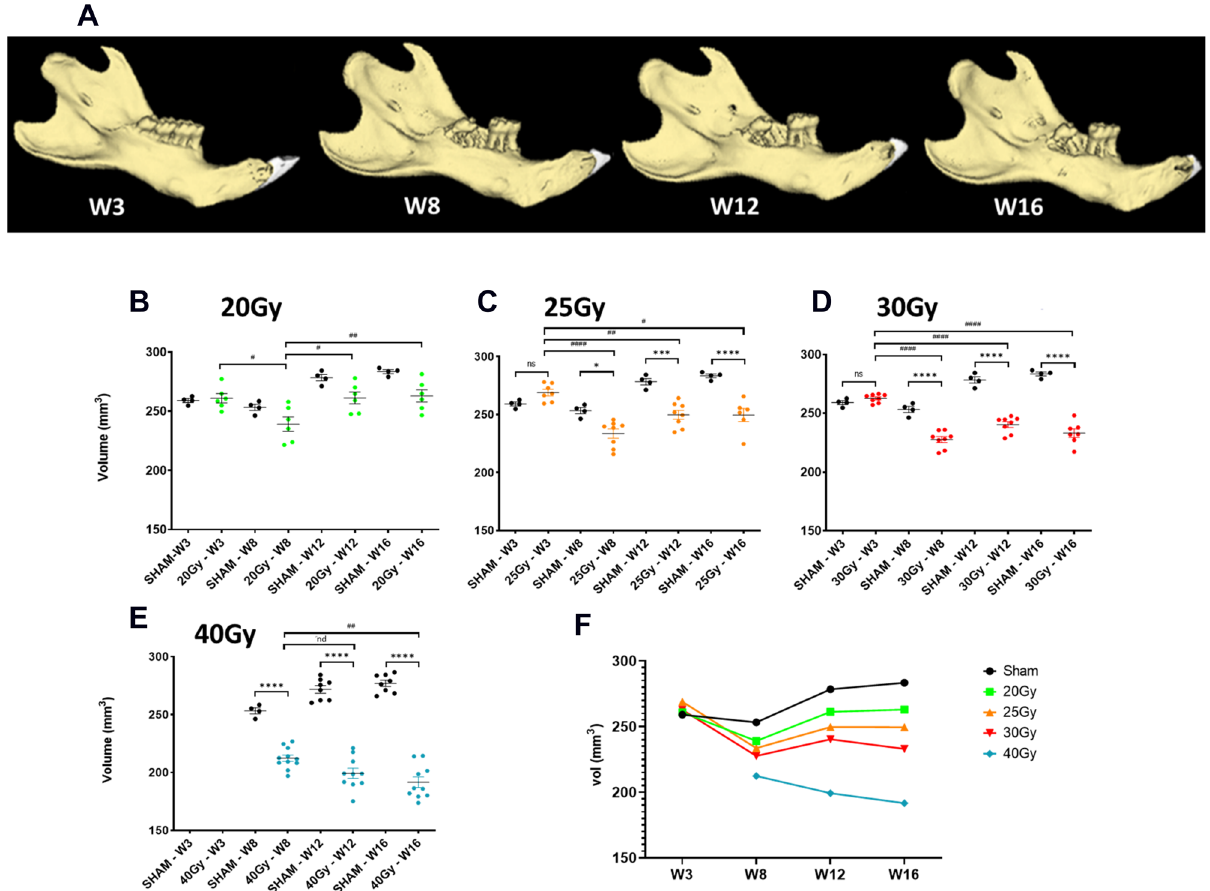
Figure 5. In vivo longitudinal study of total mandibular bone volume from 3 to 16 W. ( A ) Representative 3D reconstituted pictures of left mandible of 25 Gy irradiated rats among time. Graphics representing total bone volume of left mandible for ( B ) 20 Gy; N = 6 animals ( C ) 25 Gy; N = 7 animals ( D ) 30 Gy; N = 8 animals ( E ) 40 Gy; N = 10 animals compare to Sham N = 4. Statistical analysis: Shapiro normality test then One-way anova. ( F ) Representative graphic of total mandible change in bone volume over time including all irradiation doses. * versus sham; # versus groups. nd: no After 20 Gy irradiation, we did not detect any significant difference with regard to the sham group regardless of the time period analyzed (Fig. 5A). This demonstrates that, for a 20 Gy dose, bones heal after tooth extraction as in the sham animals. For a 25 Gy dose, no significant differences were observed at 3 W compared to the sham group, however significant bone defects were observed at 8 W with p < 0.0262 then significance with p < 0.0003 at 12 W and p < 0.0001 at 16 W compared to the sham group (Fig. 5B). The increase in difference compared to the sham group over time demonstrates a worsening of bone loss. In particular, curve variation analysis of 25 Gy irradiated rats showed no difference over time from 8 W, demonstrating the absence of bone healing after 25 Gy irradiation and tooth extraction. For 30 Gy and 40 Gy highly significant bone defects were detected as early as 8 W. For 40 Gy, we noticed a strong reduction in the bone volume at 12 W and 16 W compared to 8 W, highlight- ing bone degeneration (Fig. 5C,D). To conclude, overall analysis of the curves clearly demonstrates that at 20 Gy, bone can regenerate following molar extraction and irradiation. 25 Gy and 30 Gy irradiation doses are intermedi- ate with no major change in bone volume from 8 W and at 40 Gy the mandibular bone substantially degenerates over time (Fig. 5 F). These results were compared against the 2D measurements of the distance between the first molar and the underlying bone (Fig. 6). This method specifically targets bone resorption near the extracted zone. For the sham group, the distance measured is short and generally constant over time. For all irradiated groups, we detected a significant increase in the distance compared to sham from 12 W (Fig. 6B–E). Interestingly, this 2D measurement is the only one that highlights bone resorption at the 20 Gy dose from 12 W after irradiation. Thus, 2D distance measurement seems appropriate for quantifying local and weak bone lesions. However, maximal distance is rapidly reached limiting the quantification of significant bone damage. Differential bone defect over time on left versus right mandible. Rats were irradiated with an incident beam on the left mandible that crosses out through the right mandible, leading to irradiation of both mandibles. First, we analyzed the impact of irradiation for the right mandible. 3D volume analyses detected